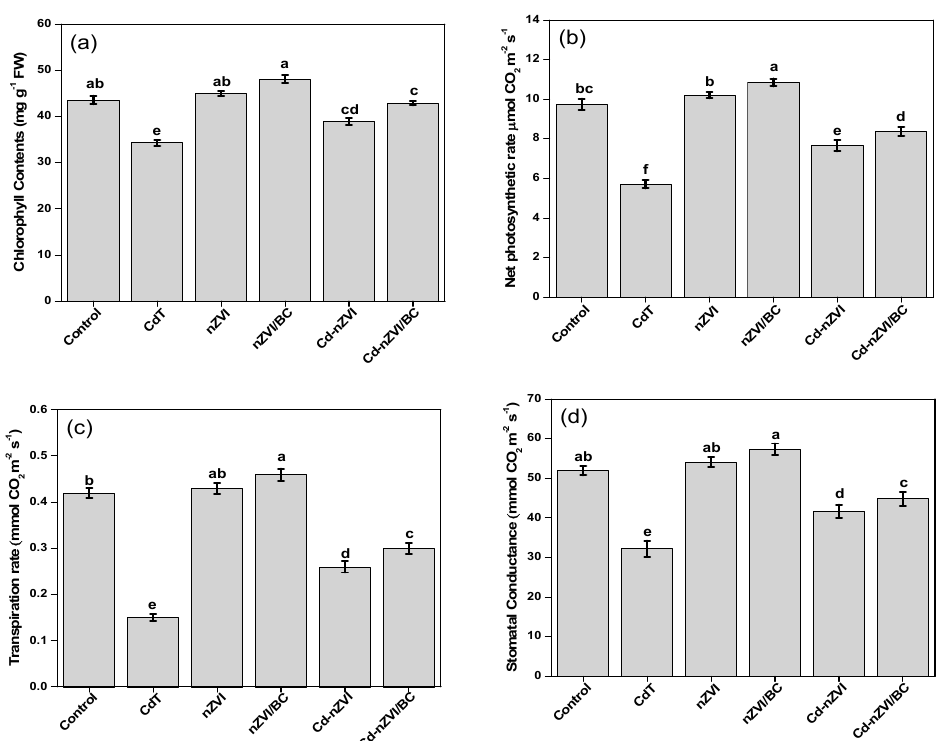
Figure 4. Impact of nZVI and nZVI/BC application on plant physiology in normal and Cd-polluted soils, ( a ) Chlorophyll contents; ( b ) Net photosynthetic rate; ( c ) Transpiration rate; ( d ) Stomatal conductance. Bars not sharing the same lower-case letter are significantly different (Tukey’s HSD α < 0.05). Represented data are the mean ( n = 6) with ± standard